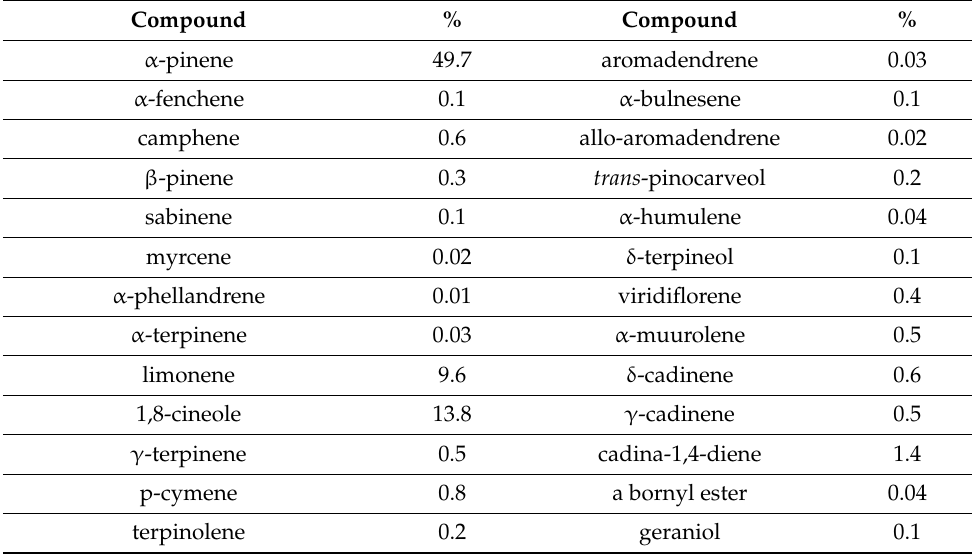
Table 8. Compounds identified in the leaf oil of Backhousia kingii